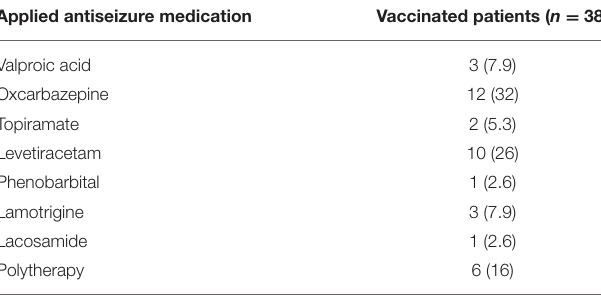
TABLE 3 | Types of applied antiseizure medications of vaccinated patients, N (%). Applied antiseizure